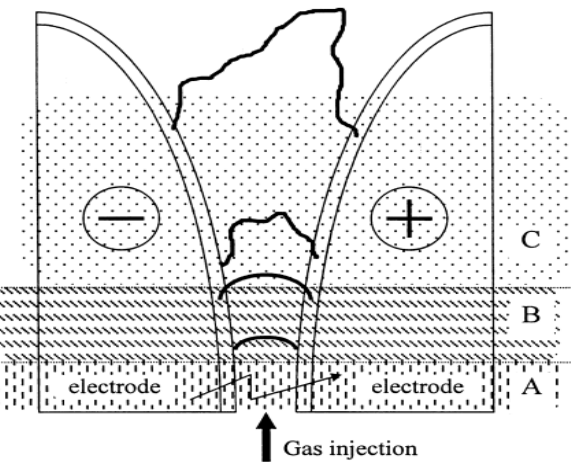
Figure 2. Steps of gliding arc process: ( A ) reagent gas break-down; ( B ) equilibrium heating phase; ( C ) non-equilibrium reaction phase [87].